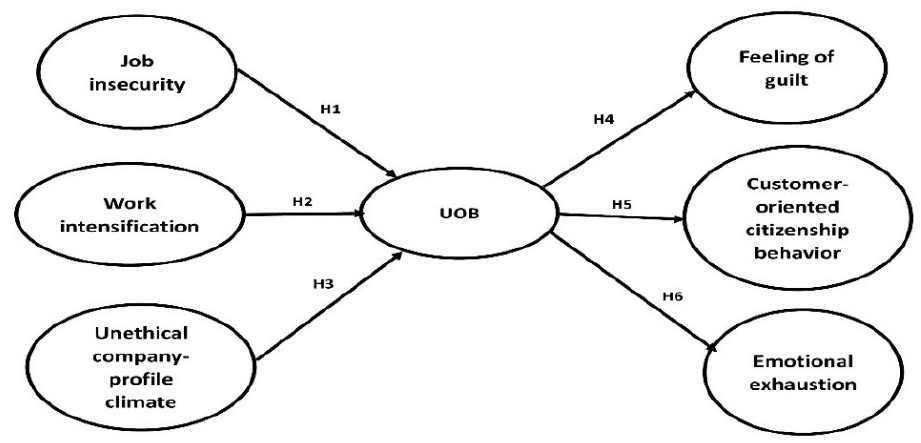
Figure 1. Research framework. Hypothesis 1 (H1). Job insecurity is associated with UOB